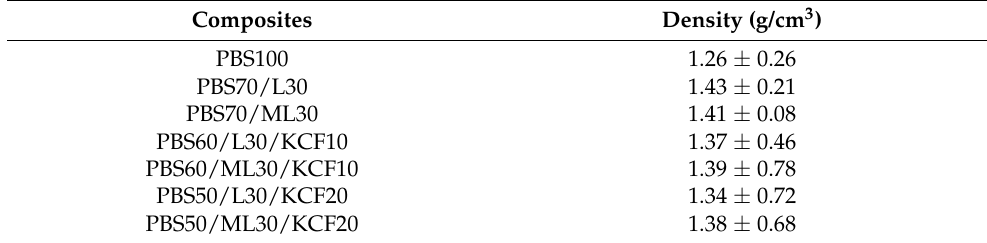
Table 2. Density of PBS and its composites.